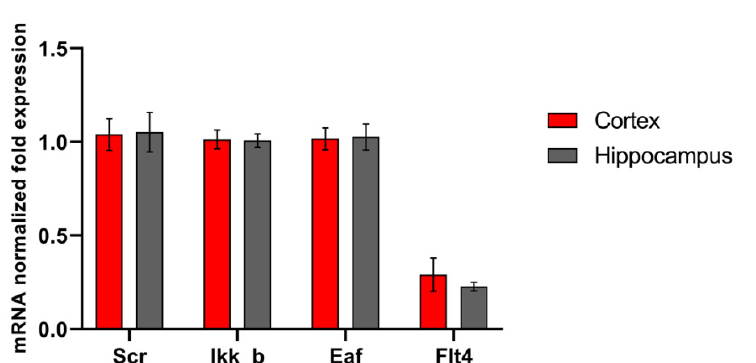
Figure 1. Features of kinase gene expression in primary cortical and hippocampal cultures. Data are normalized to the reference gene (Oaz1).